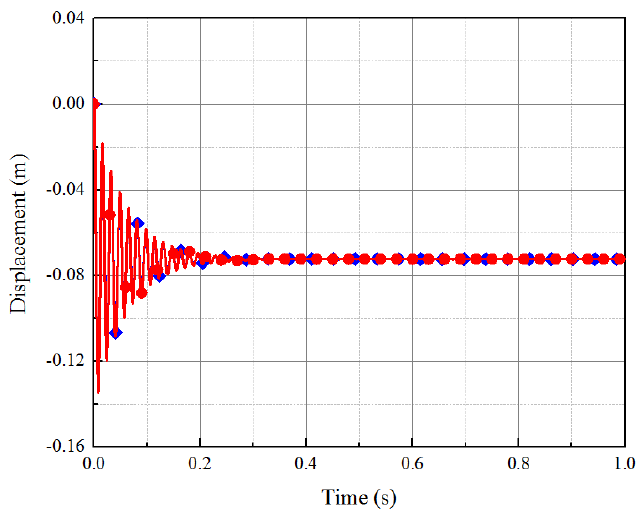
Figure 3. Transverse displacement of the middle node. ( CB method (free-free modes) and ANSYS (simply-supported modes)).